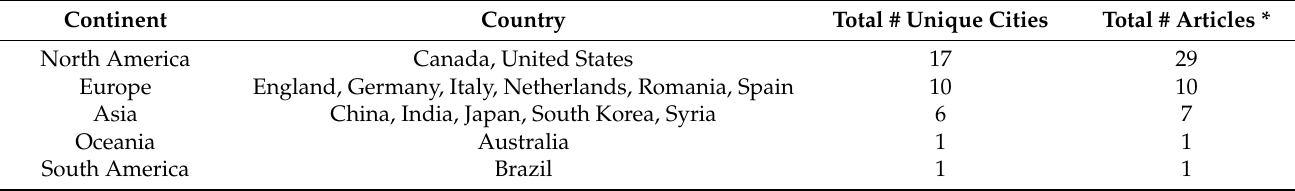
Table 2. Geographic distribution of original studies. * An original study conducted as a laboratory simulation is not included here because it is not place-specific. Continent Country Total # Unique Cities Total # Articles